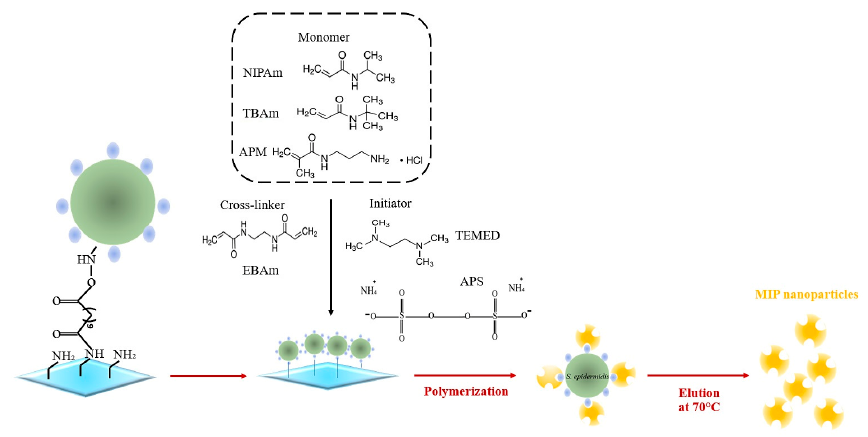
Figure 2. Schematic of MIP nanoparticle synthesis for S. epidermidis.